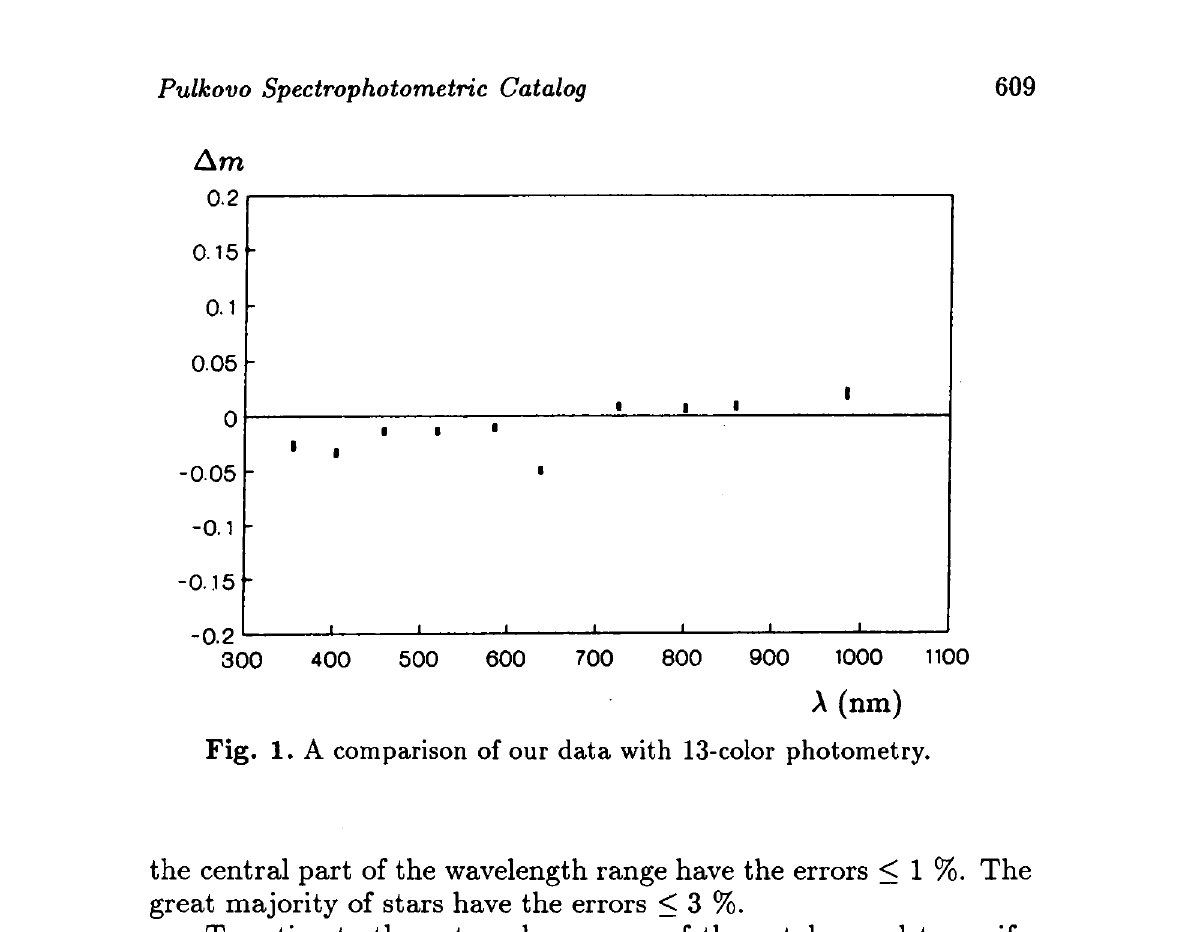
Fig. 1. A comparison of our data with 13-color